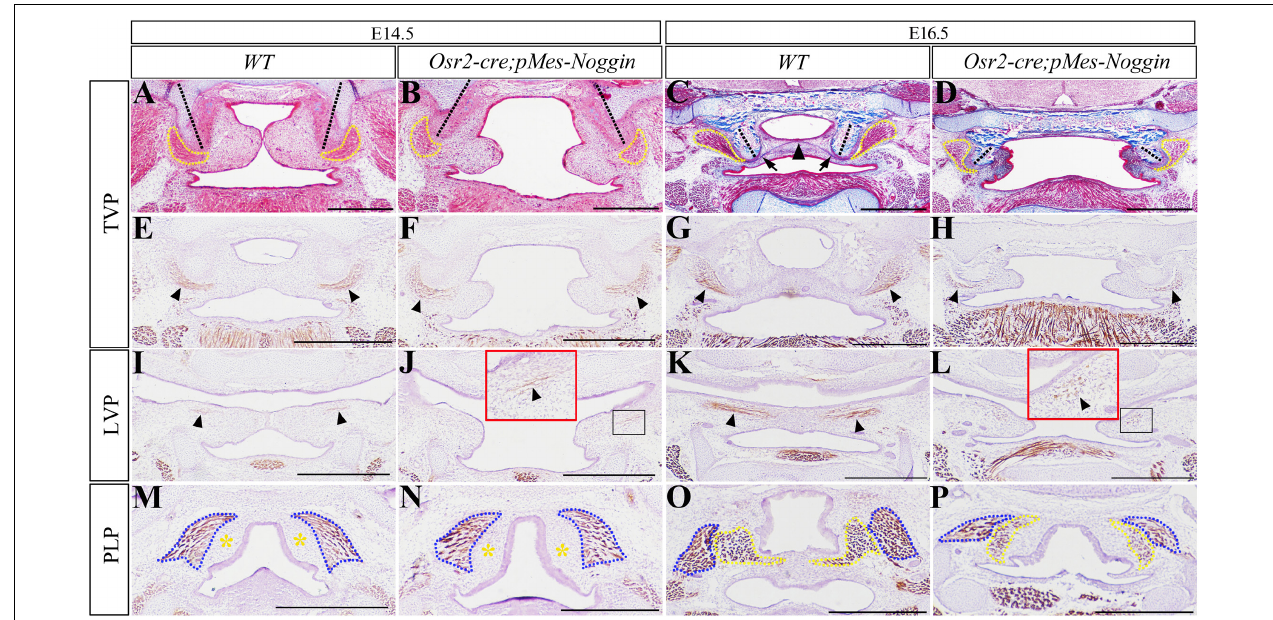
FIGURE 1 | The morphology of HPP and muscles in the Osr2-cre KI ;pMes-Noggin soft palates. (A–D) Masson staining showed the E14.5 WT soft palate (A) , the E14.5 Osr2-cre KI ;pMes-Noggin soft palate (B) , the E16.5 WT soft palate (C) , and the E16.5 Osr2-cre KI ;pMes-Noggin soft palate (D) . The dashed yellow lines outline the TVPs; the black arrowheads indicate aponeurosis; the black arrows delineate TVP tendons; and the dashed black lines stand for HPP orientation. (E–H) The myosin staining showed the TVP myofibers of the E14.5 WT soft palate (E) , the E14.5 Osr2-cre KI ;pMes-Noggin soft palate (F) , the E16.5 WT soft palate (G) , and the E16.5 Osr2-cre KI ;pMes-Noggin soft palate (H) . Black arrows indicate the TVP myofibers. (I–L) The immunostaining of myosin showed the LVP myofibers of the E14.5 WT soft palate (I) , the E14.5 Osr2-cre KI ;pMes-Noggin soft palate (J) , the E16.5 WT soft palate (K) , and the E16.5 Osr2-cre KI ;pMes-Noggin soft palate (L) . Black arrows point to the LVP myofibers; red boxes in (J,L) are the magnified images in the black boxes. (M–P) The myosin staining showed the SPC and PLP myofibers of the E14.5 WT soft palate (M) , the E14.5 Osr2-cre KI ;pMes-Noggin soft palate (N) , the E16.5 WT soft palate (O) , and the E16.5 Osr2-cre KI ;pMes-Noggin soft palate (P) . Blue dotted lines outline the SPC; yellow dotted lines circle the PLP; the yellow asterisks delineate the presumptive PLP areas. TVP, tensor veli palatini; LVP, levator veli palatini; PLP, palatopharyngeus; SPC, superior pharyngeal constrictor; HPP, hypophosphatasia. Scale bars are 200 µ m.